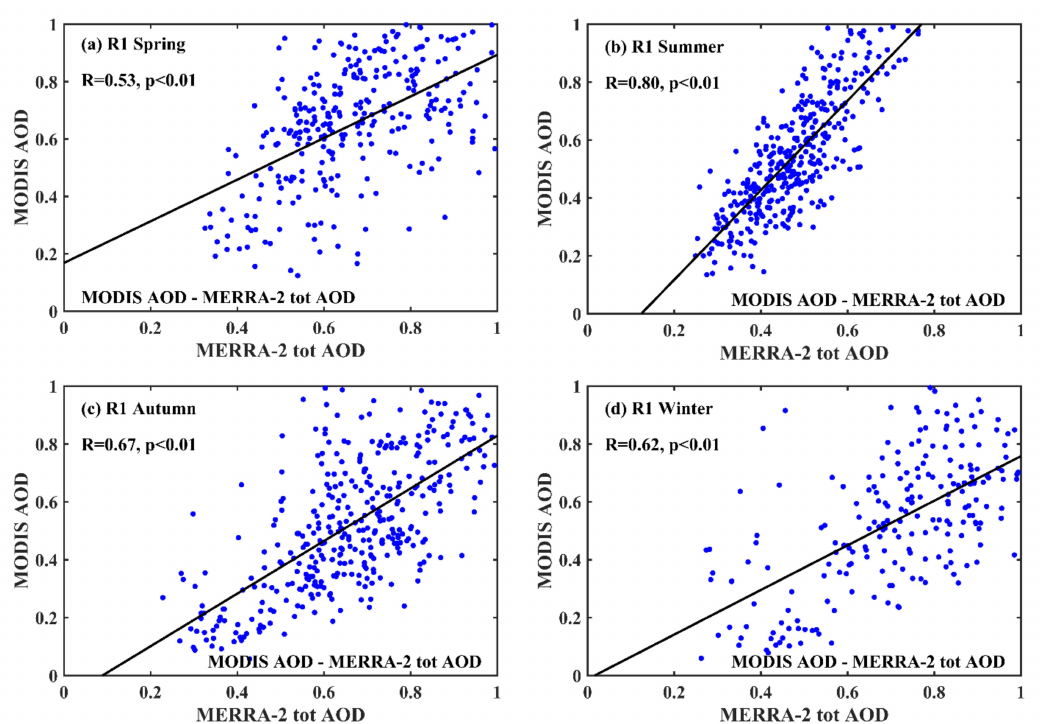
Figure A1. Scattered plots of monthly MODIS AOD (550 nm) and MERRA-2 total AOD (550 nm) for four seasons (spring: March, April, and May; summer: June, July, and August; autumn: September, October, and November; winter: January, February, and December) over R1 during 2010–2018. Values of correlation coefficients (R) and significance level (p) are also given in each panel.